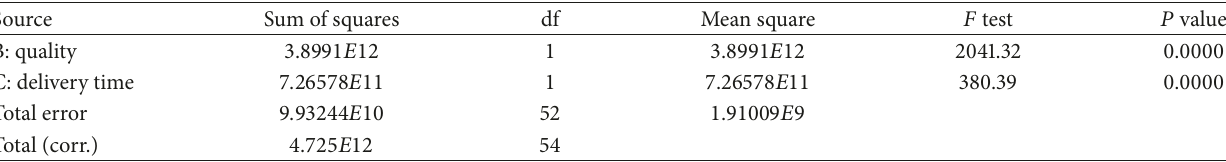
Table 3: Analysis of variance for profit (adjusted model).